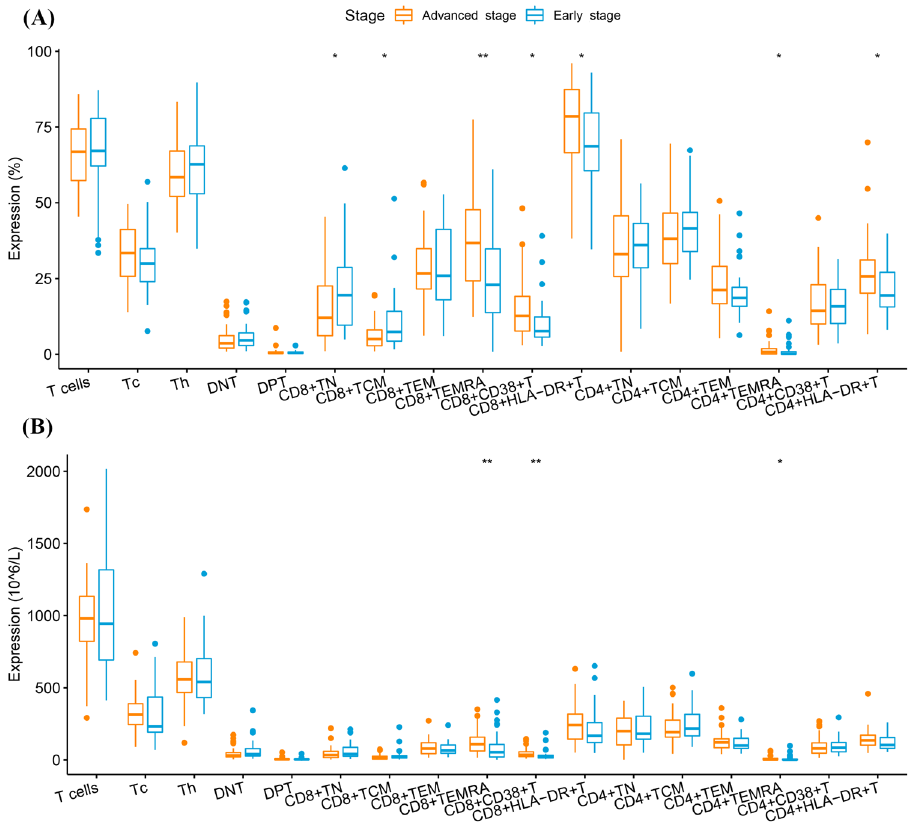
Figure 3. Differences in T lymphocyte subsets between the early- and advanced-stage groups. ( A ) Proportions of T lymphocyte subsets. ( B ) Absolute counts of T lymphocyte subsets.